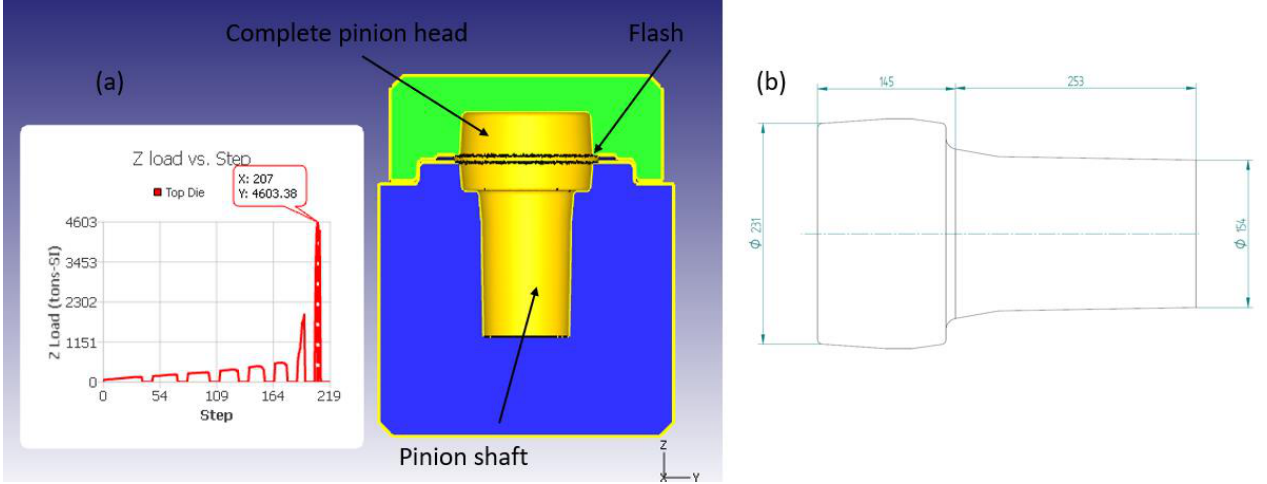
Figure 5. ( a ) Top die load exerted by the workpiece during flash formation, ( b ) drawing of the forged part (dimensions in mm).